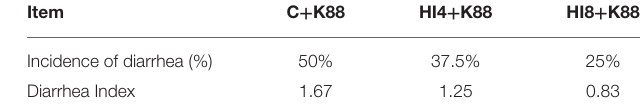
TABLE 6 | Effect of Hermetia illucens larvae on diarrhea rate and diarrhea index of weaned piglets after intragastric administration of ETEC K88.